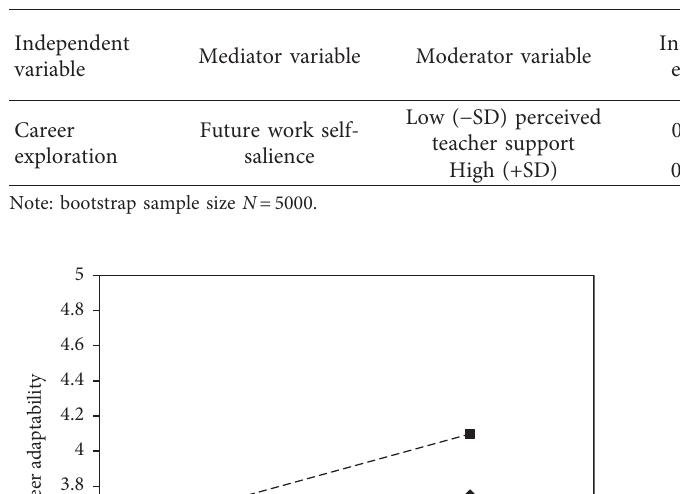
Table 5: Moderated mediation bootstrap test.